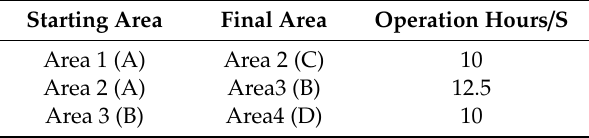
Table 9. AGV running time between di ff erent